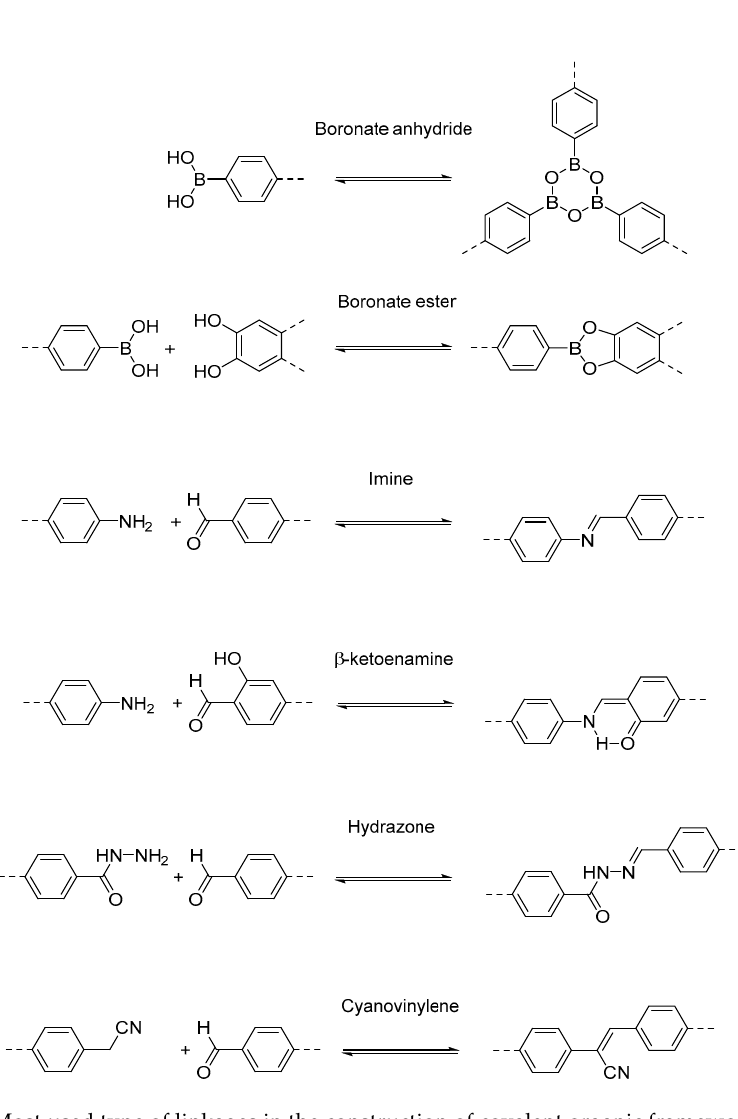
Figure 1. Most used type of linkages in the construction of covalent organic frameworks (COFs).